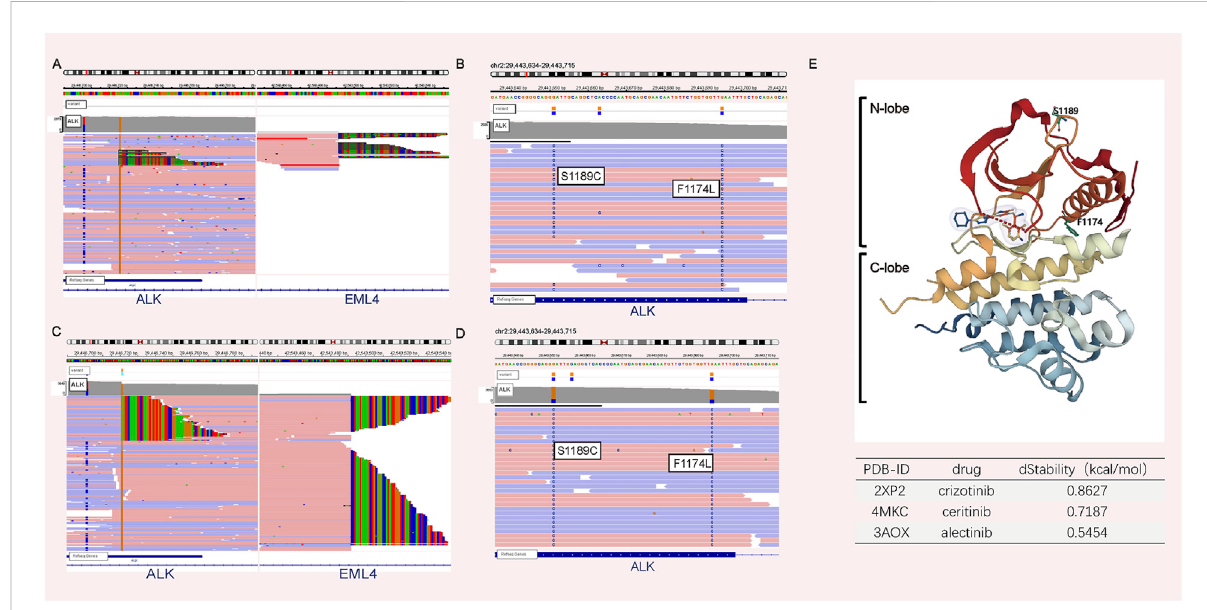
FIGURE 3 NGSanalysesbeforeandaftertherapy.NGSanalysisbeforecrizotinibtreatmentrevealedthepresenceoftheALKfusion (A) plustheF1174L-cis- S1189C mutation (B) . NGS analysis after crizotinib and ceritinib treatment revealed the presence of the ALK fusion (C) plus the F1174L-cis-S1189C mutation (D) . (E) ALKstructureretrievedfromPDB2XP2. Insilico mutagenesisofhumanALKbindingtothreeALKinhibitorcomplexes(PDBID:2XP2, PDB ID: 4MKC, and PDB ID: 3AOX) was used to predict the variable in fl uence on protein stability. The dStability and relative thermostability of the mutation with respect to the wild-type protein are shown in the